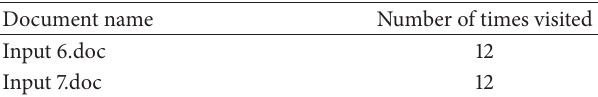
Table 2: Frequently visited documents.